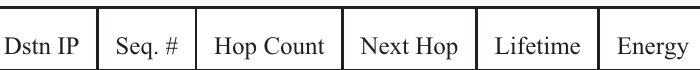
Figure 4. Proposed RREP message format.